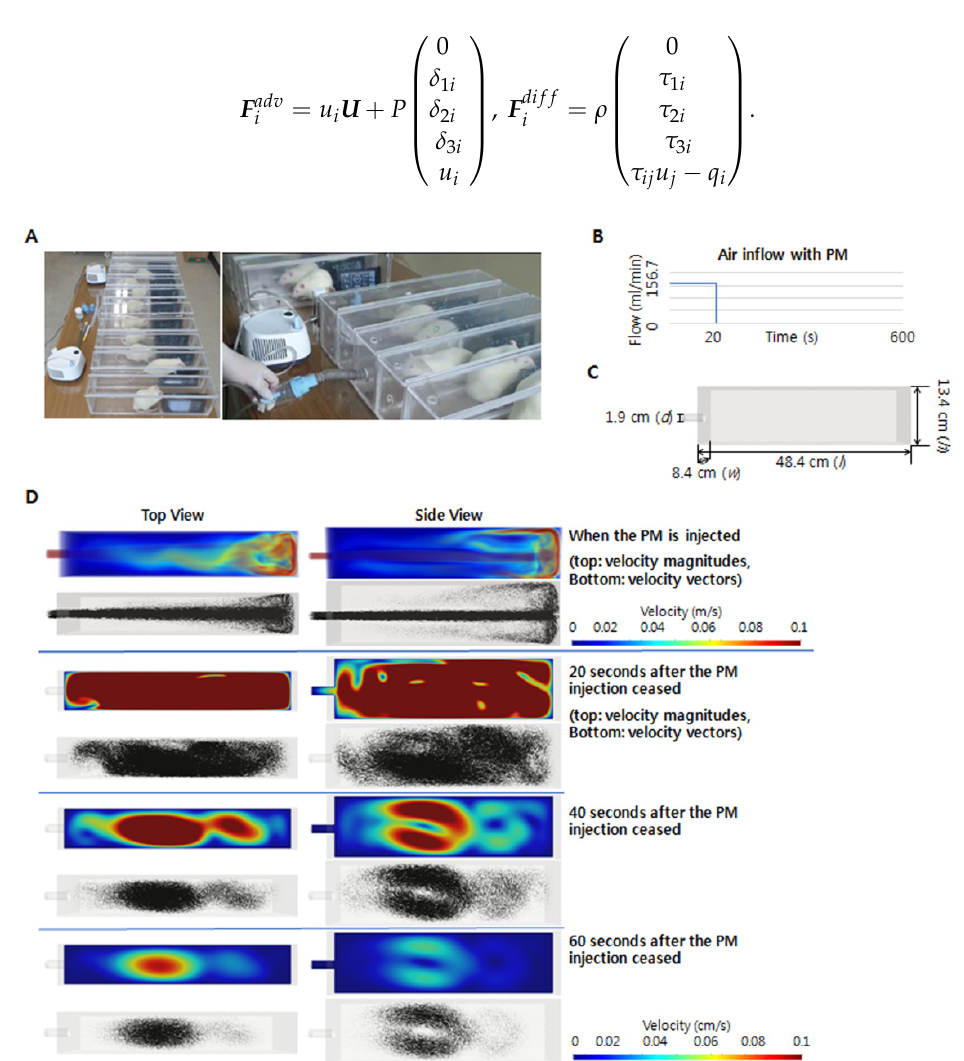
Figure 8. Methods followed for the PM exposure experiments. ( A ) Gross images of PM exposure using closed chambers and nebulizer systems. ( B ) Air inflow rate of the PM sample. ( C ) Dimensions of the closed chambers. ( D ) Simulations of the PM flow in the closed chamber 0, 20, 40, and 60 s after PM injection. d, diameter; w, width; l, length; h,